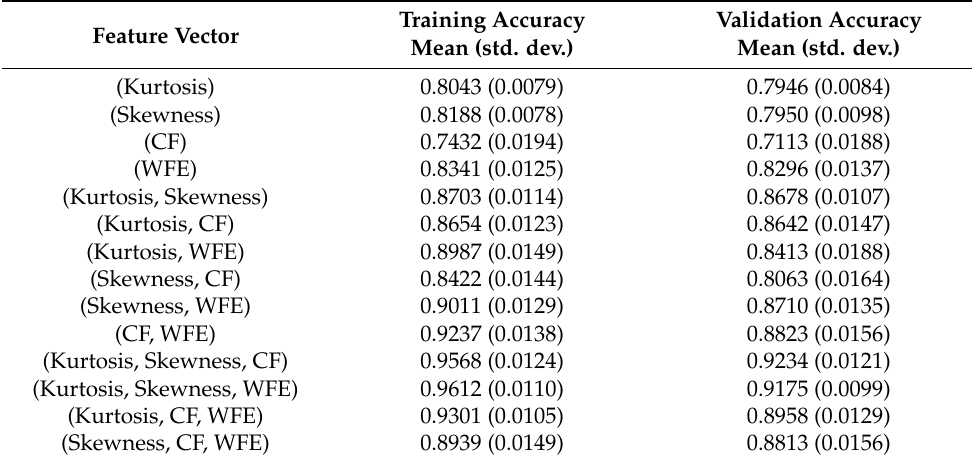
Table 4. Accuracy of trained LSTM by using feature